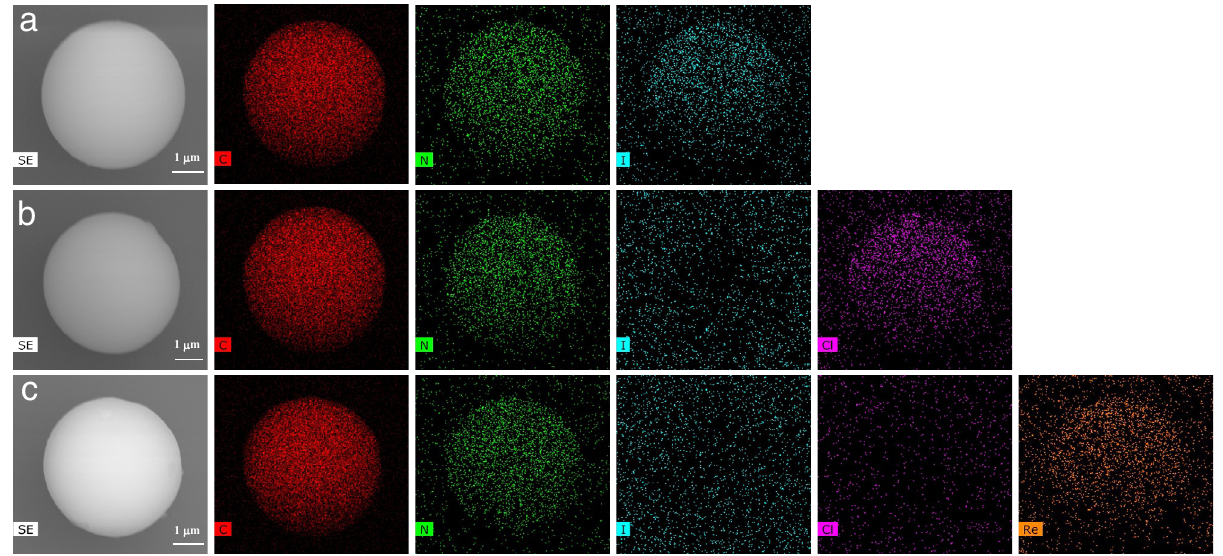
Fig. 5 | EDS mapping. a TFPM-PZI, b TFPM-PZ-Cl, c TFPM-PZ-Re. C (red), N (green), I (blue), Cl (pink), Re (yellow).